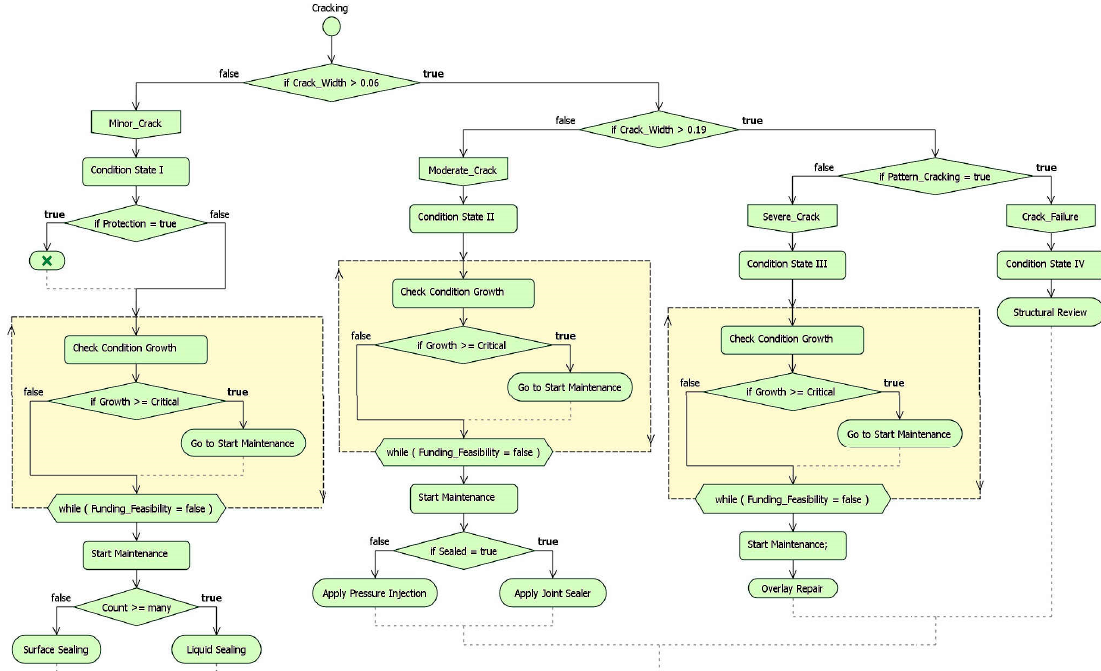
Figure 14. Example maintenance action tree for concrete bridge deck cracking based on FDOT’s practice.